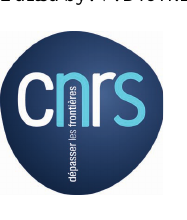
Fig. A2. PC3 loadings for DIC, SST and fluorescence. Note that principal component loadings are correlation coefficients between − 1 and 1.